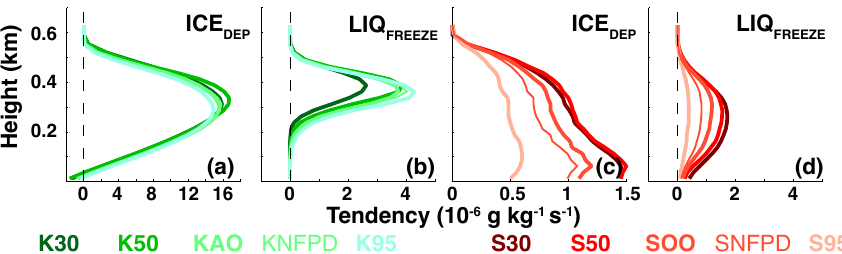
Fig. 9. Vertical profiles of domain-averaged microphysical tendencies for the second half of the 12h simulation period from simulations featuring different soluble mass fractions (color coded at bottom). Simulations assume Kaolinite (a–d) or Soot (e–h) as the insoluble mass type Included are profiles of ice depositional growth tendency (a, c) and liquid freezing tendency (b, d) .